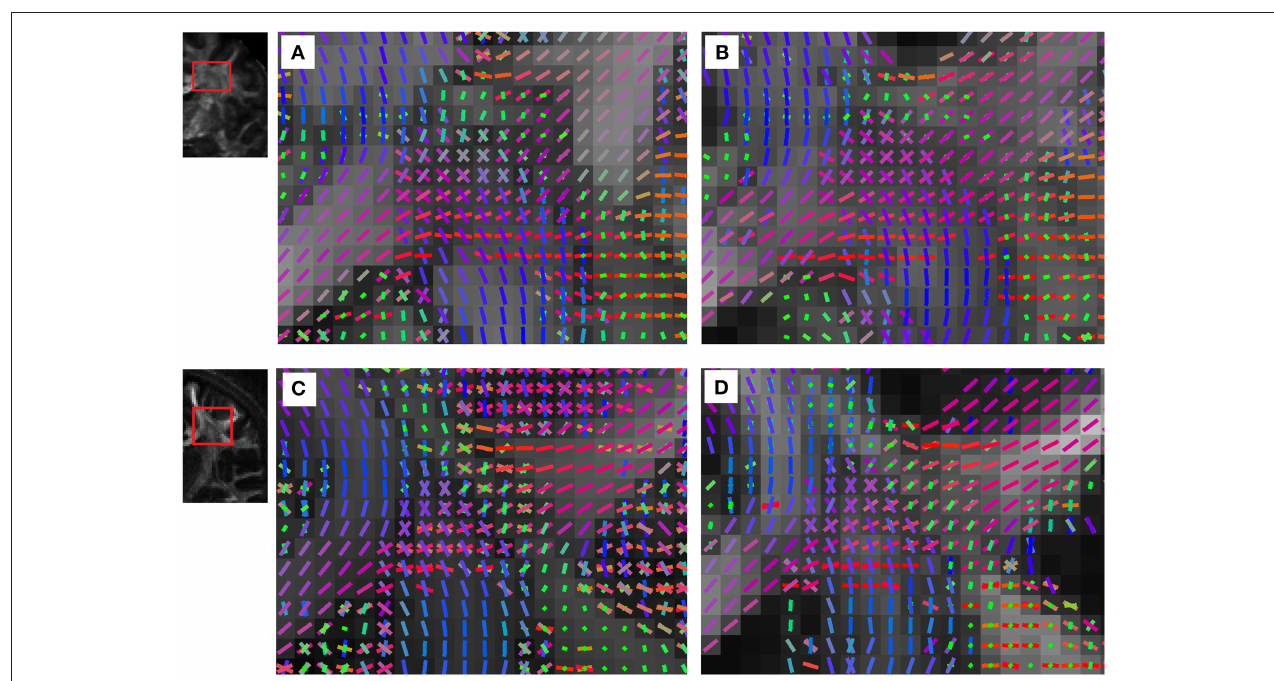
FIGURE 6 | The fiber orientations resolved by (A) CSD applied to the multi-shell data of the WU-Min consortium using our scheme conversion method, (B) ball-and-sticks model applied to the same WU-Min consortium data, (C) CSD applied to the DSI data of the USC-MGH consortium using our scheme conversion method, and (D) DSI reconstruction applied to the same USC-MGH consortium data. The data converted from and multi-shell and DSI achieve a comparable angular resolution, and the crossing fibers can be readily resolved.